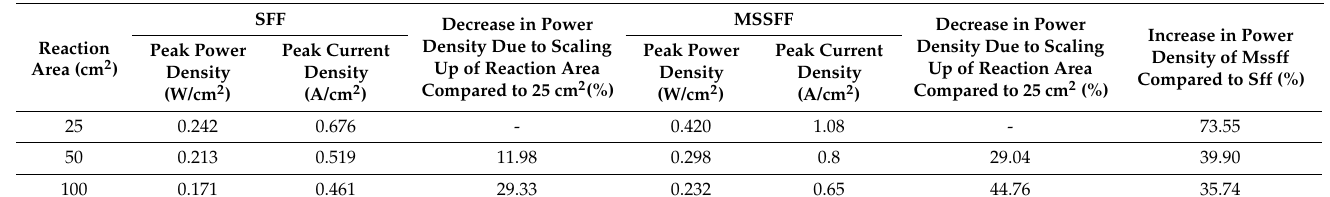
Table 4. Influence of changing flow field designs and increasing the reaction areas of PEMFC.